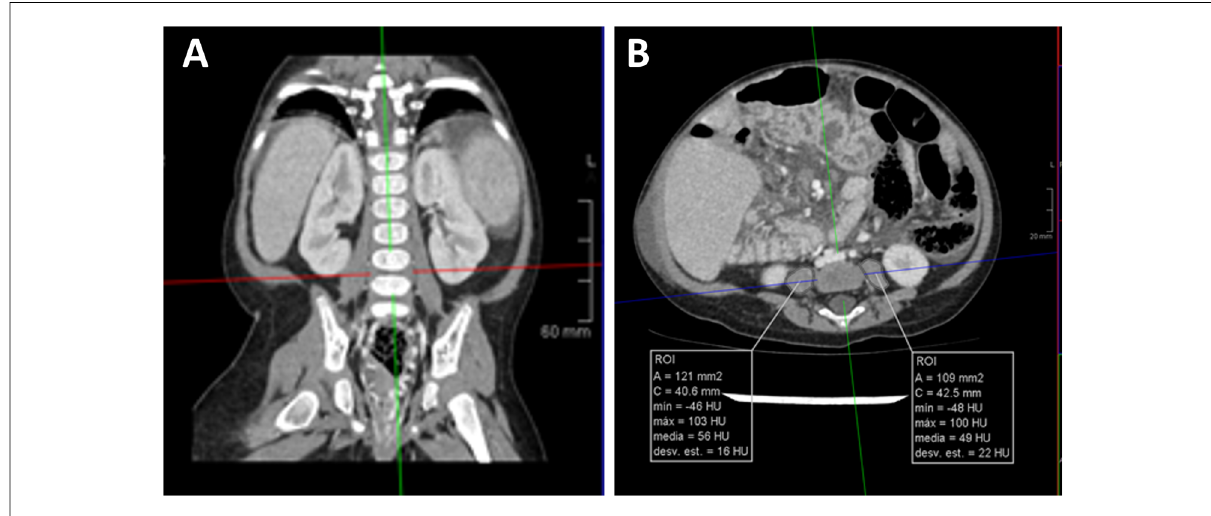
FIGURE 1 Measurement of psoas muscle mass in CT scan. Panel ( A ). From axial CT images, L4-5 level was identi fi ed following cross-referencing on sagittal and coronal plane reconstruction (red line in left image). Panel ( B ). On axial cross-sectional CT images, cross-sectional area of the psoas muscle (white lines in right image) was measured using a dedicated free-hand drawing